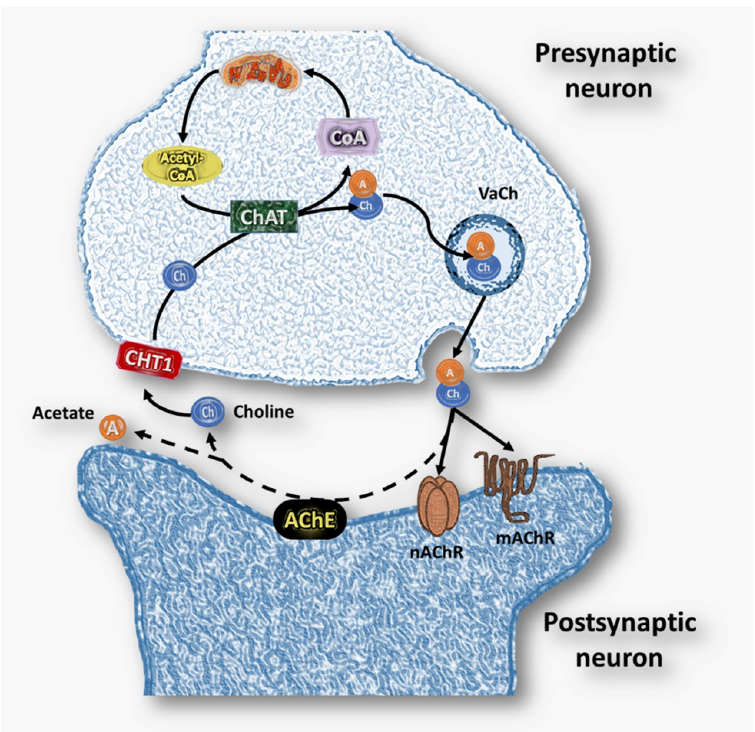
Figure 2. Neuronal cholinergic system. Ch: Choline; A: acetate; ACh: acetylcholine; AChE: acetylcholinesterase; ChAT: choline acetyltransferase; VaCh: ACh vesicles; mAChR: muscarinic ACh receptor; nAChR: nicotinic ACh receptor.